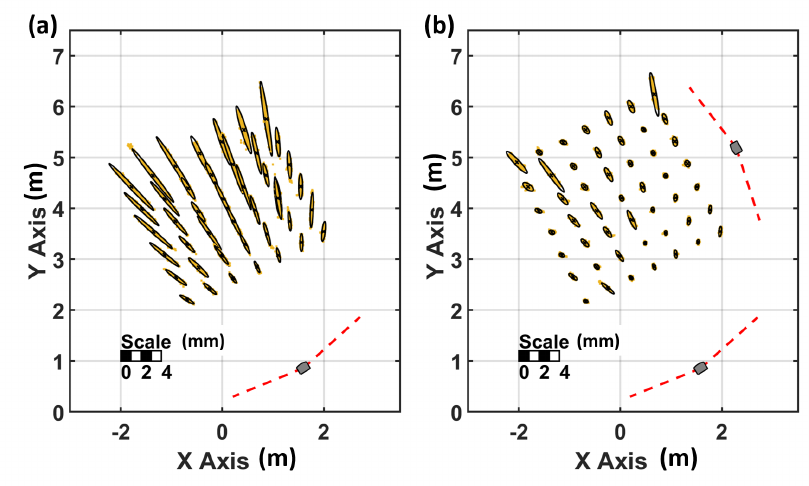
Figure 5. Noise pattern of the Tracker with one ( a ) and two lighthouses ( b ).